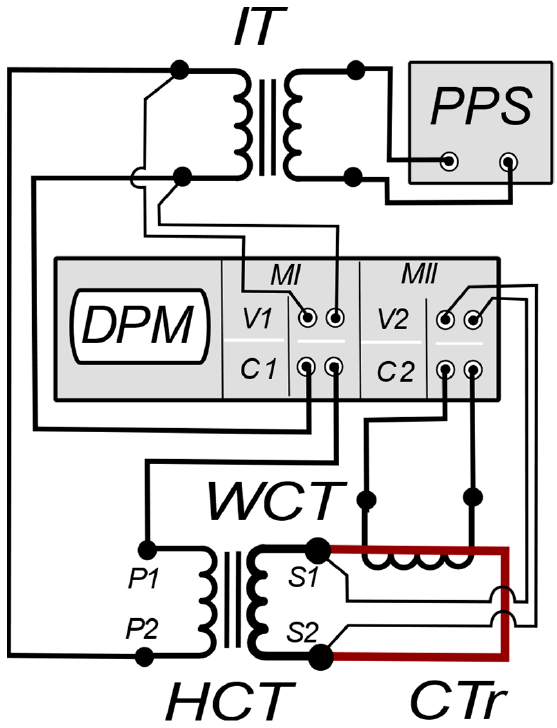
Figure 1. Measuring circuit used to determine the wideband performance of the HCT .